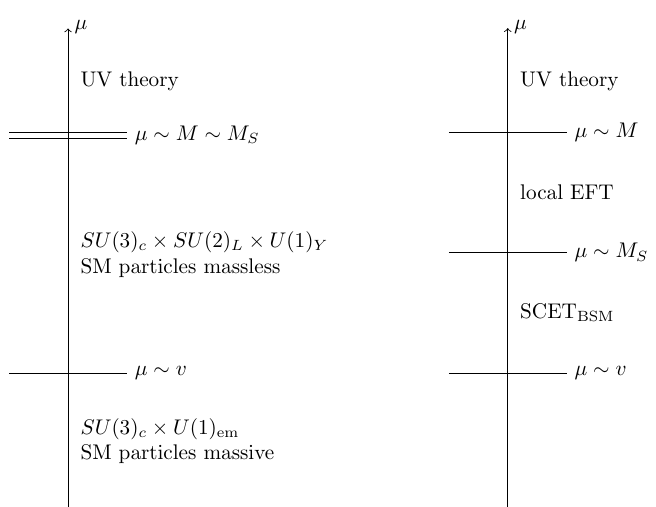
Figure 1 . Schematic description of the construction of the SCET (left), and for the case of a double hierarchy M where we have used that (cid:22) n i